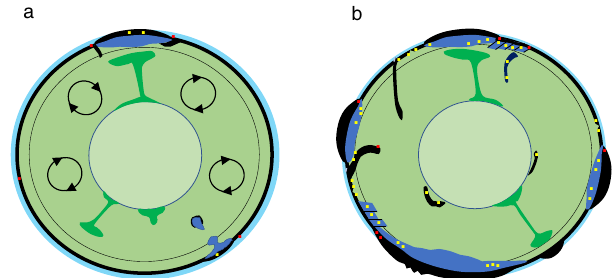
Fig. 5 A cartoon that explains the cooling of the Earth and rehydration of the mantle by low- δ 18 O fl uids in spreading centers 14,15 , plate bending zones 52 , and subduction zones 53,56 , generating progressively lower δ 18 O (and overall heterogeneous) continental lithospheric mantle (darker blue) after initiation of plate tectonics. Δ ′ 17 O is not signi fi cantly modi fi ed by these processes (Fig. 4). Color code: yellow: low- δ 18 O peridotites, red: high- δ 18 O sediments, basalts, and eclogites, green: primitive mantle plumes, light blue: oceans. a Early Earth and moon regimes: degassed mantle, plume tectonics, rudimentary subduction around plumes, and intense hot mantle convection. The δ 18 O of the original peridotites is 5.57 ± 0.07 ‰ , and Bulk Silicate Earth = Bulk Silicate Moon. b Modern plate tectonics regime: rehydration of mantle, plate accretion, and imbrication, lower- δ 18 O peridotites in the subcontinental lithospheric mantle samples by studied xenolith